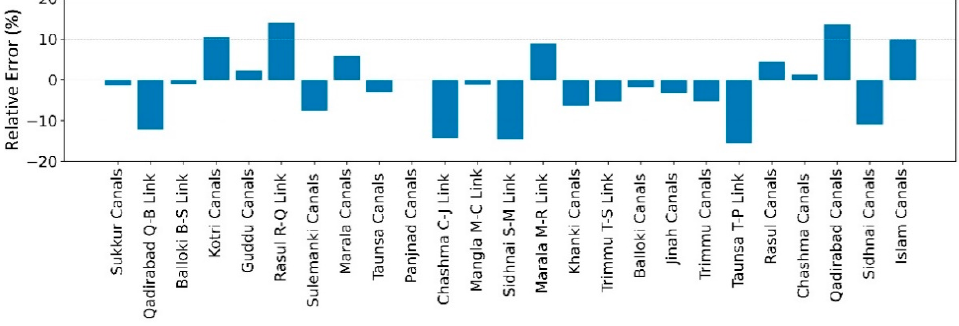
Figure 9. Mean annual modelled relative volumetric error (%) for 2002–2012 at canals and offtakes.